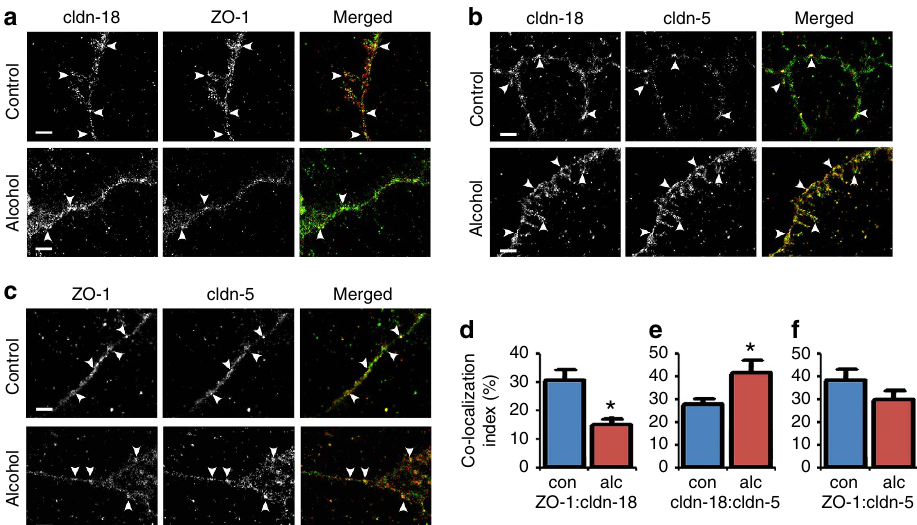
Figure 4 | Claudin-5 induced by alcohol decreases ZO-1:claudin-18 co-localization as determined by super-resolution microscopy. ( a – c ) AECs isolated from alcohol (alc) or control (con) fed rats were cultured, immunolabeled and imaged by STORM. Cells were double-labeled for claudin-18 and ZO-1 ( a ), claudin-5 and claudin-18 ( b ) or claudin-5 and ZO-1 ( c ). Images were analyzed for protein co-localization ( d – f ). Alcohol exposed AECs showed a reduction in the co-localization between claudin-18 and ZO-1 and an increase in co-localization between claudin-18 and claudin-5. Co-localization between claudin-5 and ZO-1 was comparable for both control and alcohol exposed cells. Arrowheads denote areas of co-localization. Bar, 1 m m. ( d – f ) Quantification of co-localization using STORM images demonstrated a significant change. In alcohol-exposed AECs there was a significant decrease in ZO-1:claudin-18 ( n ¼ 4 fields (control), n ¼ 3 fields (alcohol exposed AECs),* P ¼ 0.014, unpaired two-tailed t -test) ( d ) which correlated with a significant increase in claudin-18:claudin-5 co-localization ( n ¼ 3 fields, * P ¼ 0.039, unpaired two-tailed t -test) ( e ). ZO-1:claudin-5 co-localization was unchanged ( n ¼ 4 fields, unpaired two-tailed t -test) ( f ). Data in ( d – f ) represent average ± s.e.m. extractability of claudin-18, claudin-5 and ZO-1 by Triton X-100.